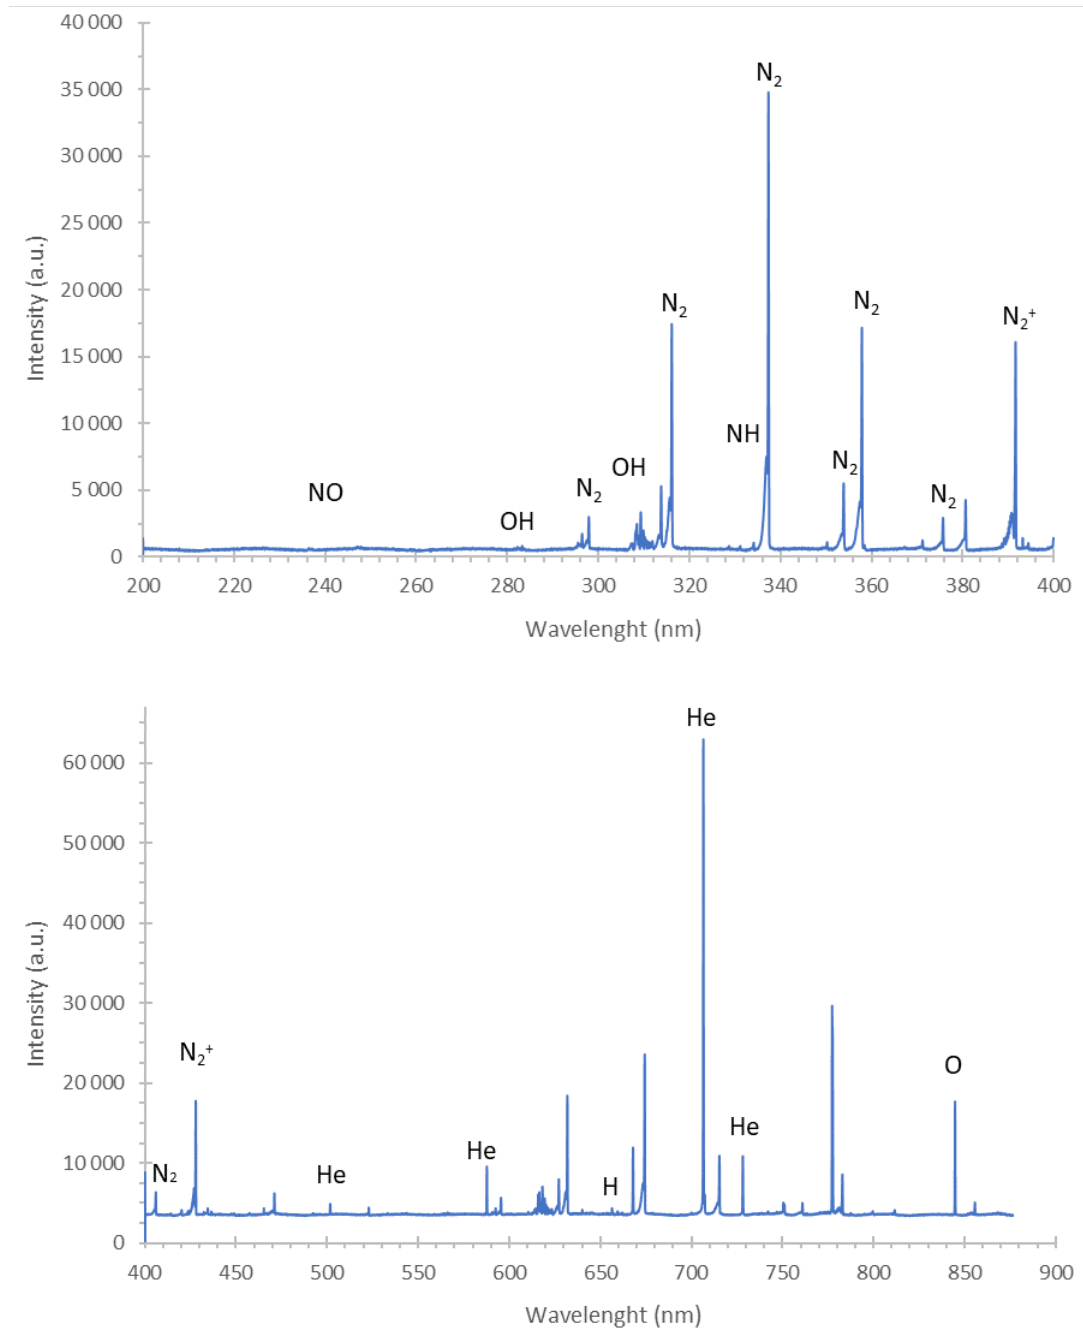
Figure 5. The emission spectra of DBD acquired in the range from 200 to 900 nm. Secondly, the TEM imaging revealed deviations in the morphology of 5-min NTAPP- treated D. solani IFB0099 cells in contrast to the untreated controls (Figure 6). Such abnor- malities in the bacterial morphology, mostly related to changes in the smoothness of the cell surface, associated with the disruption of the bacterial cell wall, were also observed by Park et al. [33], who visualized five-minute Ar-NTAPP-treated Staphylococcus aureus cells in contrast to the untreated controls with scanning electron microscopy (SEM). Fur- thermore, Olatunde et al. [34] reported the plasma triggered deformations of Pseudomonas aeruginosa , Vibrio parahaemolyticus , Escherichia coli , Listeria monocytogenes, and S. aureus cells as imaged by SEM. There [34], shrinking, etching, aggregation, and harsh poration of the five-minute DBD-treated bacteria were shown. Regarding TEM-based visualizations,